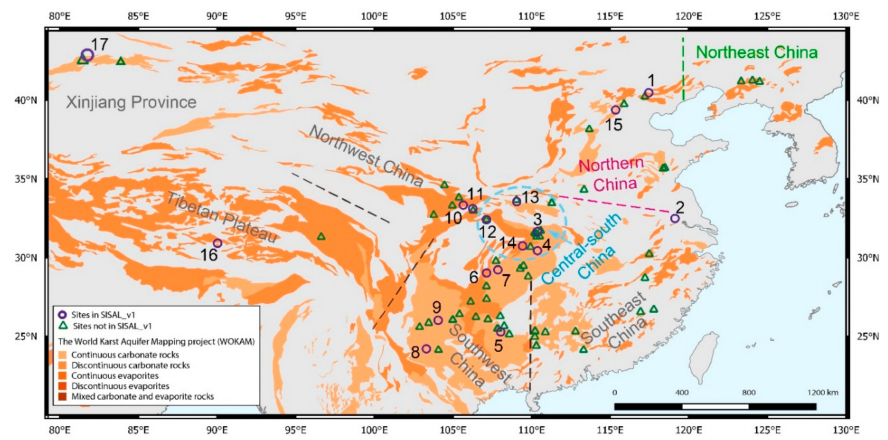
Figure 1. Map showing the location of speleothem records in China, superimposed on a map showing the distribution of carbonate and evaporite rocks provided by the World Karst Aquifer Mapping Project (WOKAM [30]). Purple circles indicate cave sites with speleothem records that are available in SISAL_v1 [18] (1: Kulishu; 2: Hulu; 3: Sanbao; 4: Heshang; 5: Dongge; 6: Yangkou; 7: Furong; 8: Xiaobailong; 9: Zhuliuping; 10: Huangye; 11: Dayu; 12: Suozi; 13: Jiuxian; 14: Xinya; 15: Xinglong; 16: Tianmen; 17: Kesang). Green triangles show cave sites identified, but not included in SISAL_v1.Specific information on sites, entities, and references is given in Table